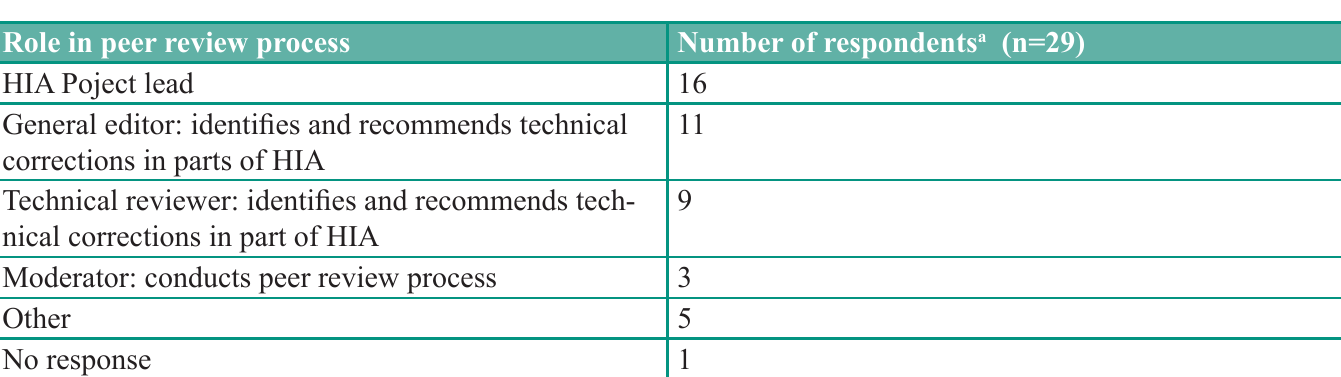
Table 2: Respondents’ role in HIA peer review